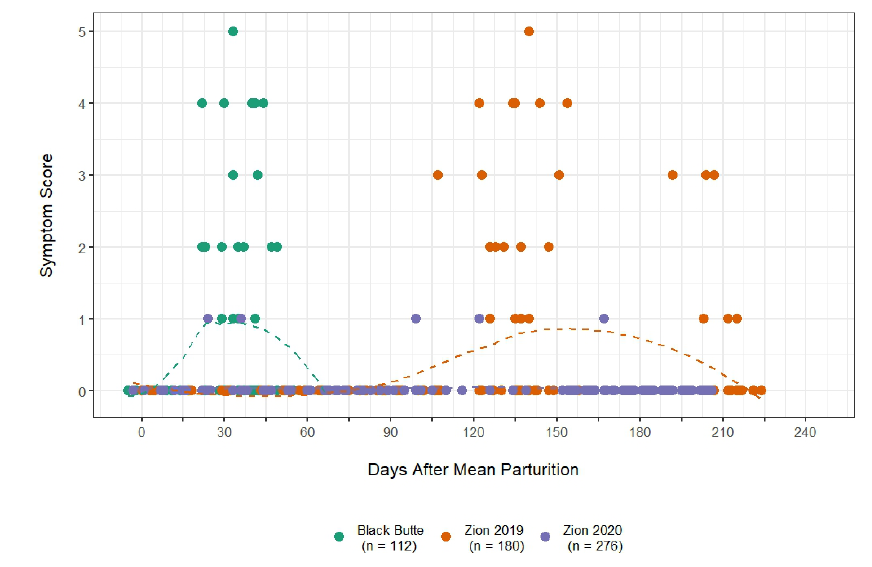
Figure 3. Symptom emergence patterns in Zion lambs in 2019 (orange) and 2020 (purple) in contrast to emergence in lambs from the Black Butte population (green) of Rocky Mountain bighorn sheep in 2014 (data from [16]). Lines are locally weighted least-squares lines fit to the Black Butte and Zion datasets. The same data, but aligned by day-in-year as opposed to lamb age, are presented in Figure